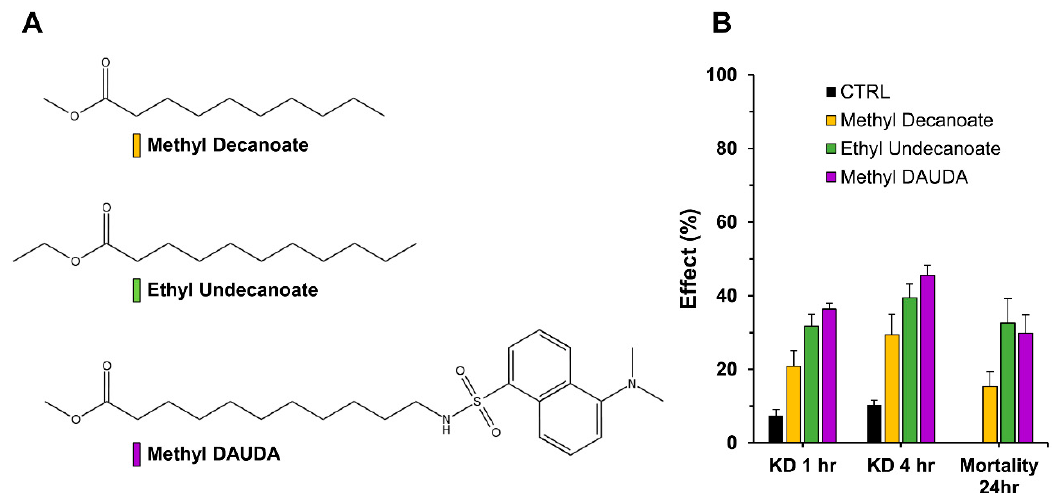
Figure 4. Fatty acid esters and topical application. ( A ) Structures of methyl decanoate, ethyl undecanoate, and methyl DAUDA. These three compounds were topically applied to An. gambiae adult females. ( B ) At a screening dose of 1 µg per An. gambiae mosquito, percentages of knockdown and mortality are reported.